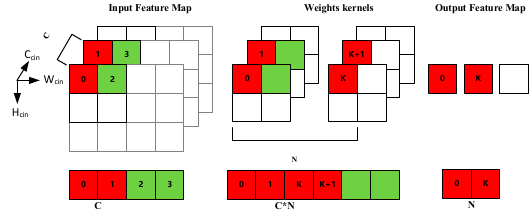
Figure 5. Vectorized data structure.